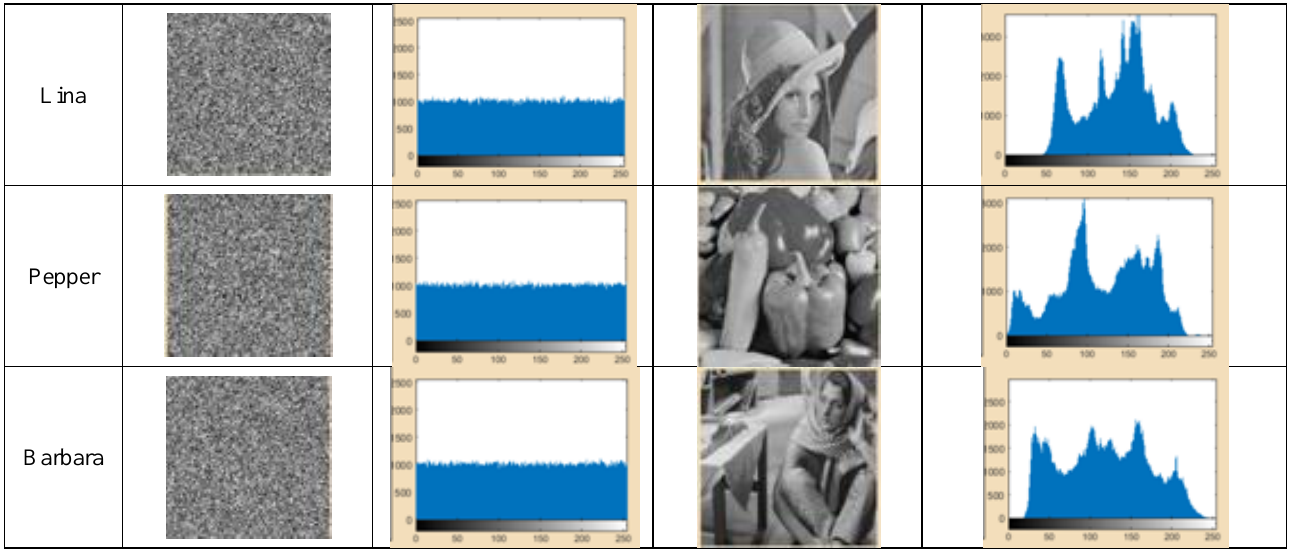
Figure 8. Column 2 and column 3 are DWT-DES compressed-encrypted image and corresponding histograms with respect to images as in column 1; Column 4 and Column 5 are decrypted-decompressed image and its corresponding histograms with respect to images as in column 1